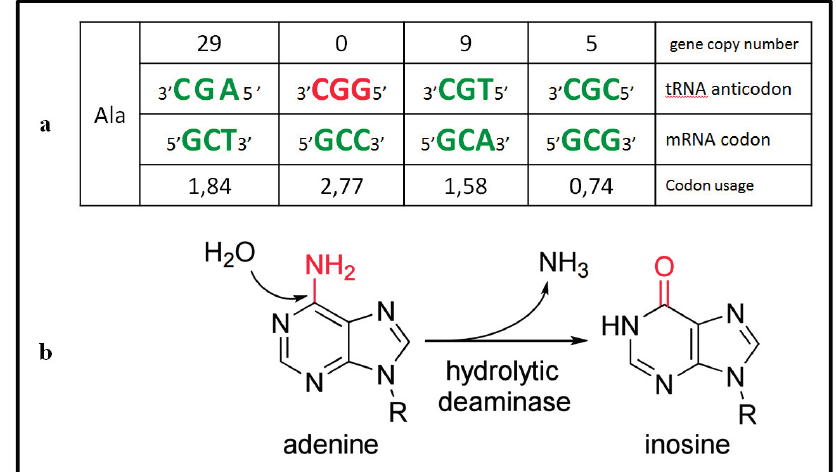
Figure 1. ( a ) Codon–anticodon relation for ADAT-related alanine amino acid. tRNA copy number and codon usage is shown for each pair, note that (cid:1872)(cid:1844)(cid:1840)(cid:1827) (cid:3008)(cid:3008)(cid:3004)(cid:3002)(cid:3039)(cid:3028) do not exist in human (red nucleotides); ( b ) Hydrolytic deamination: Adenine is converted into an inosine throughout a hydrolytic deamination